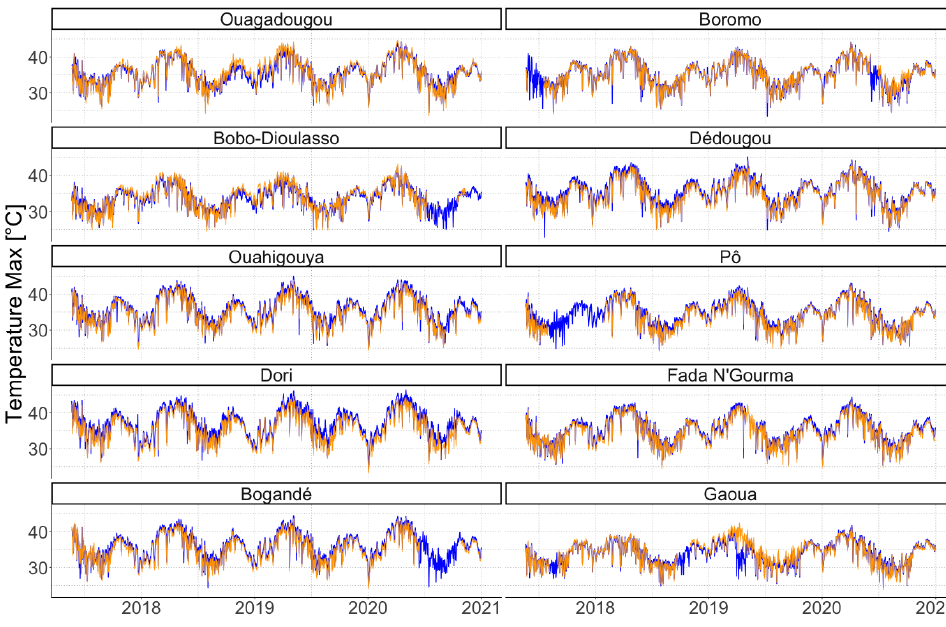
Figure 6. Comparison of maximum temperature time series between TAHMO stations (in orange) and the corresponding stations from meteorological service of Burkina Faso (in blue). An overall good agreement becomes apparent between the two time series. Large MVs are visible especially for the stations Boromo, Bobo-Dioulasso, Pô, Bogandé and to a lesser extend for